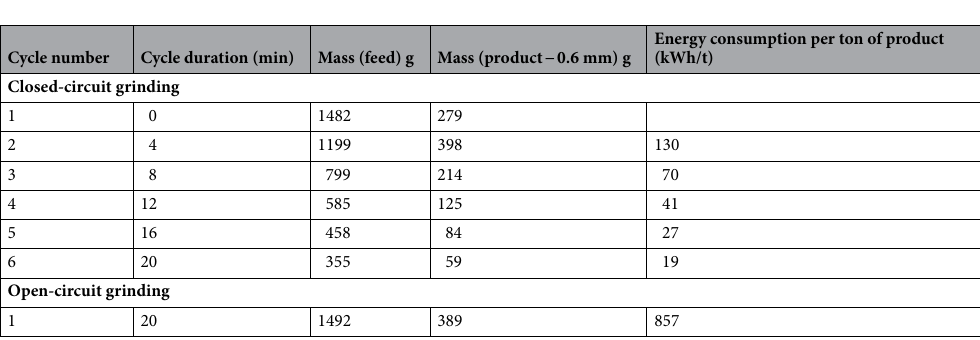
Table 2. Mass balance and energy consumption for both open and closed grinding